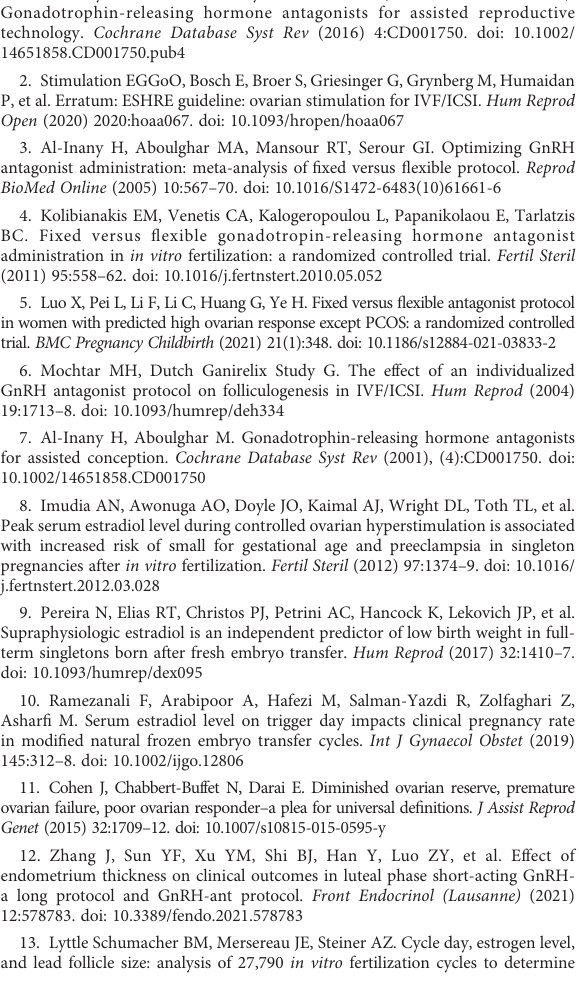
SUPPLEMENTARY FIGURE 1 Descriptive analysis of the serum estradiol level on the day of GnRH-ant initiation. GnRH-ant, gonadotropin releasing hormone